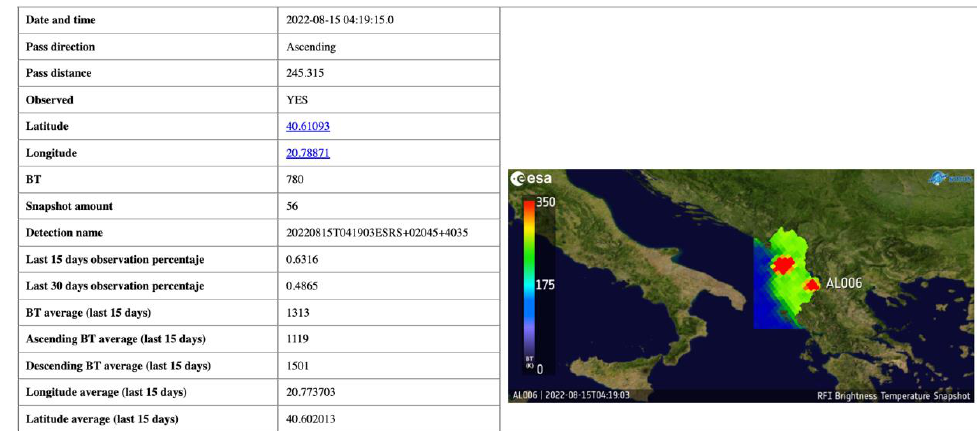
Figure 11. Information within a SMOS pass and BT snapshot associated with an RFI.